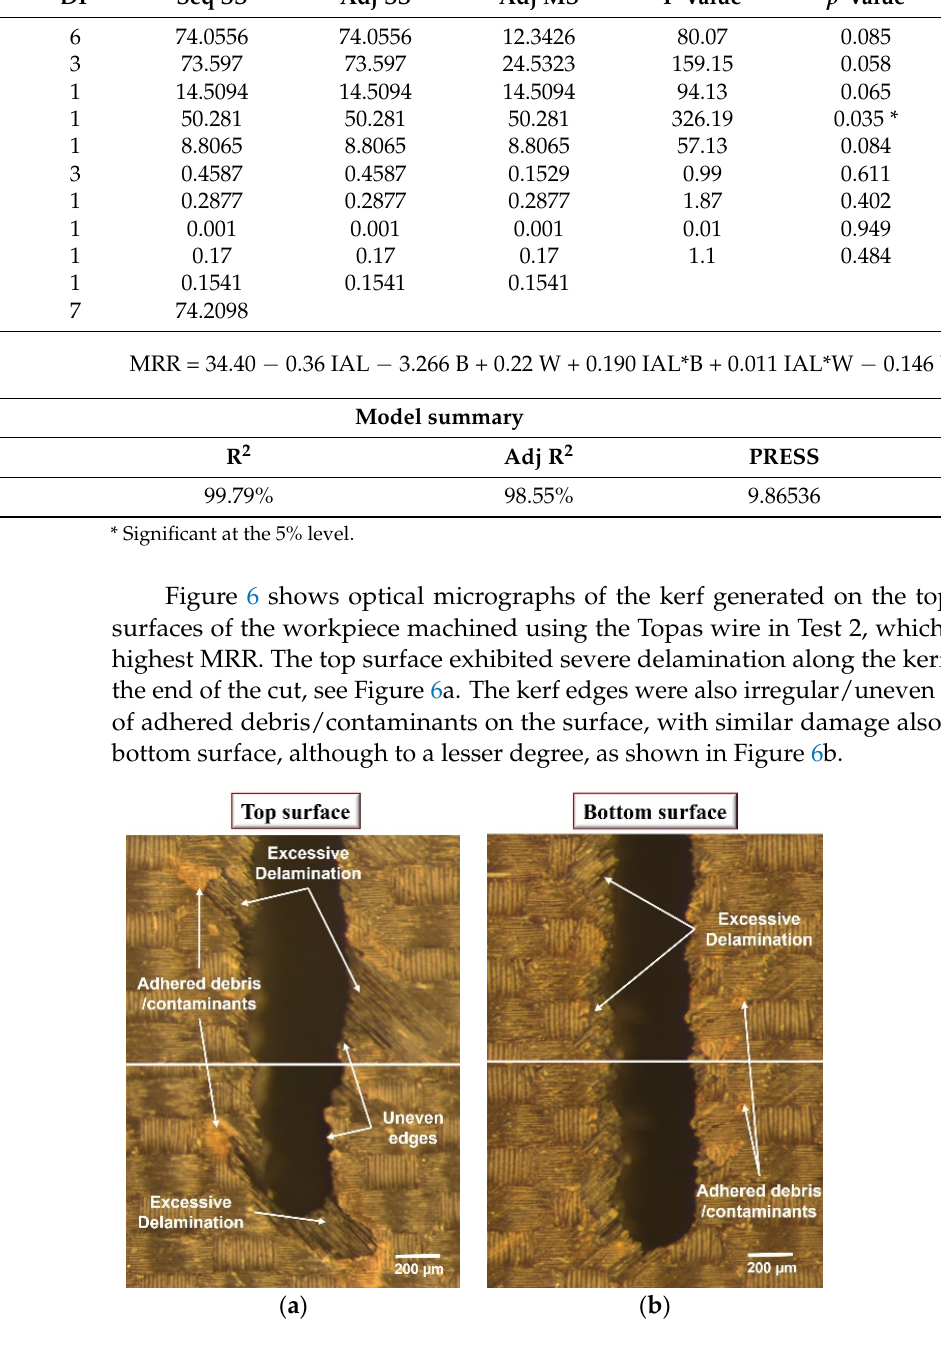
Table 4. ANOVA for material removal rate including interactions.